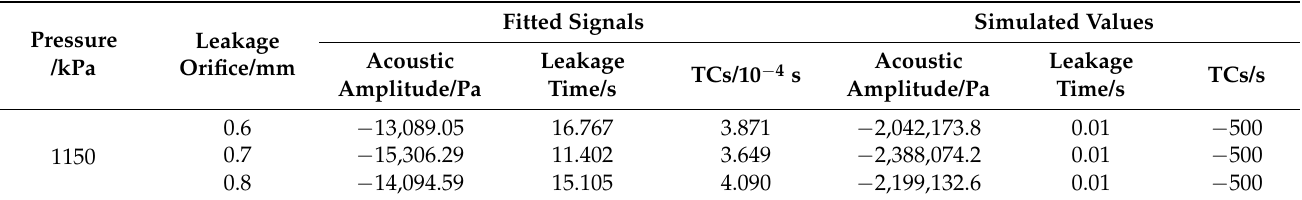
Table 1. Acoustic amplitudes and